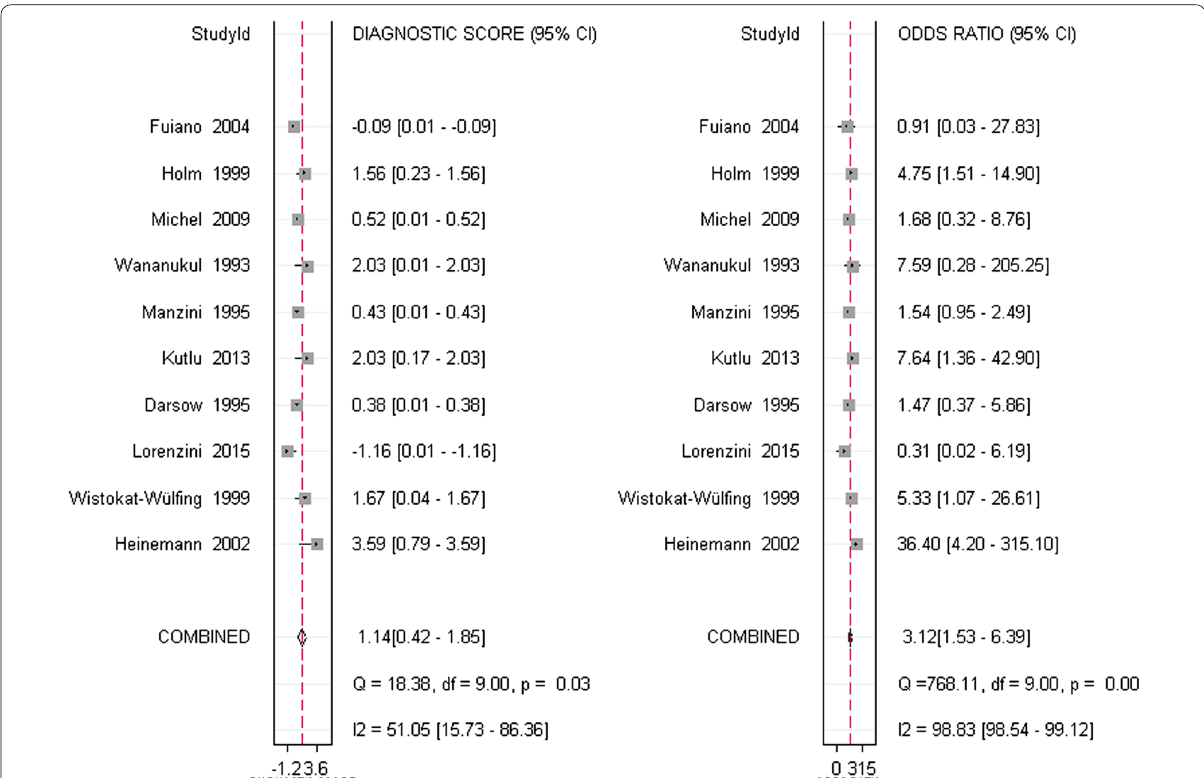
Fig. 6 The combined diagnostic score and odds ratio (OR) of APT in comparison to SPT for the diagnosis of patients with atopy dermatitis. CI confi- dence interval, ES estimates